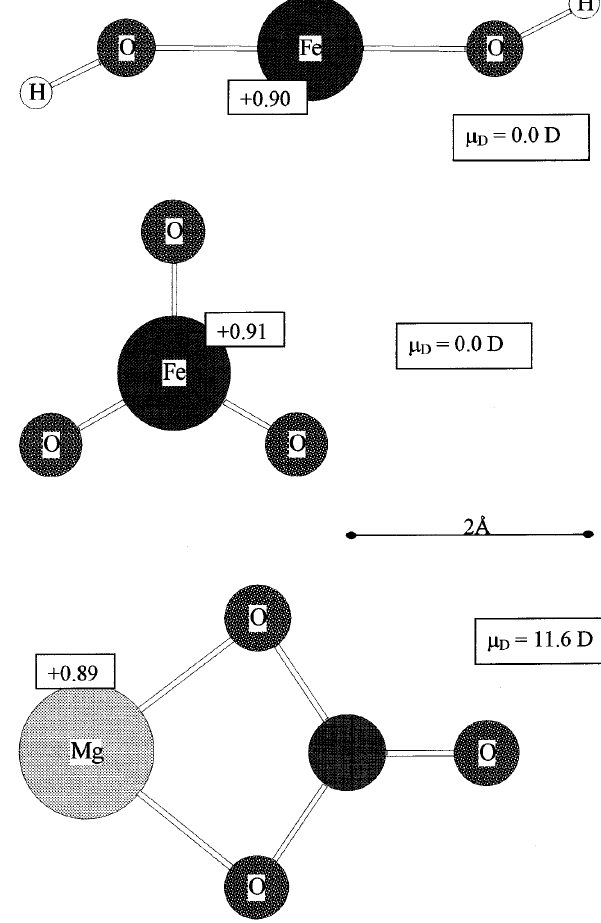
Fig. 7. Geometries and dipole moments ( l MgCO , calculated at the B3LYP/6-311+G(2d,p) level of theory. All 3 structures are planar. The dark shaded atomic centre